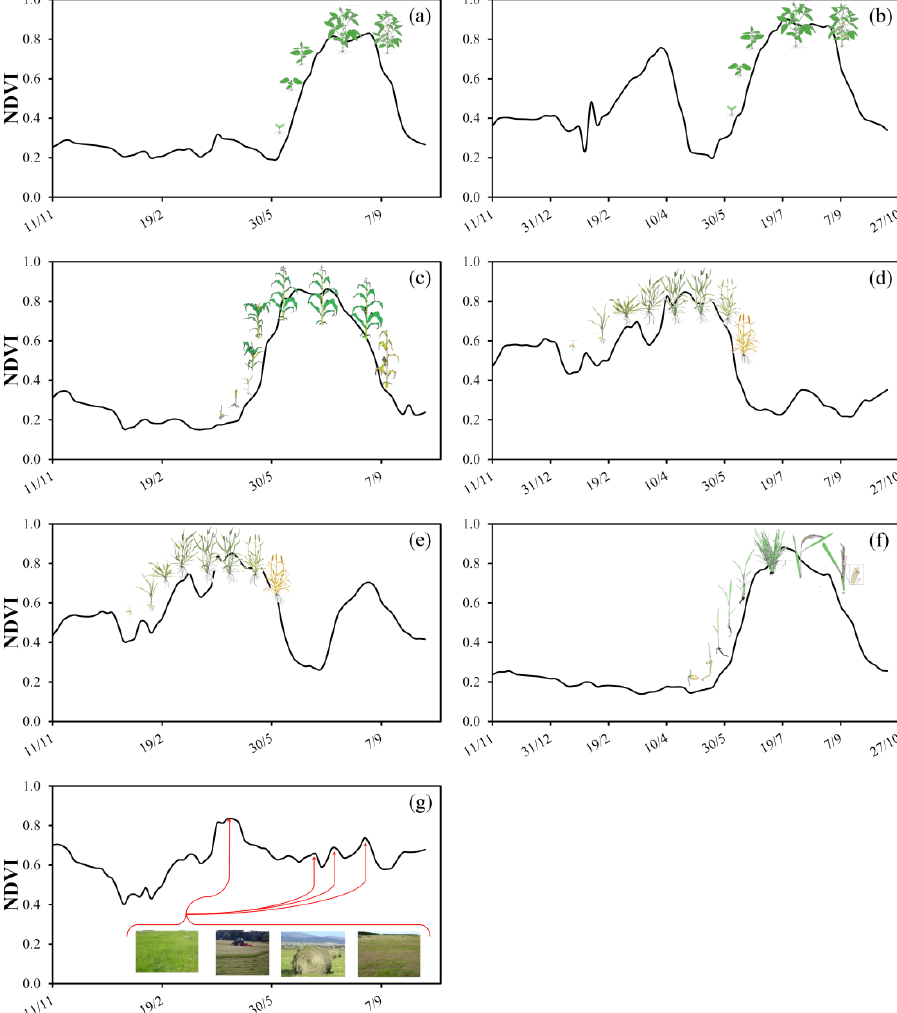
Figure 4. Examples of Normalized Difference Vegetation Index (NDVI) temporal profiles. They describe, at pixel level, NDVI evolution over time. ( a ) Soybean; ( b ) Soybean in succession with other crops; ( c ) Corn; ( d ) Wheat; ( e ) Wheat in succession with other crops; ( f ) Rice; ( g ) Meadow.